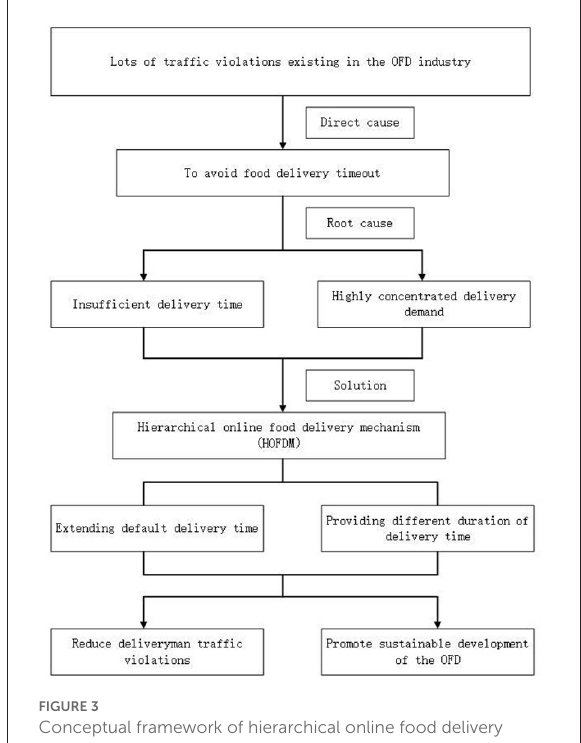
FIGURE3 Conceptual framework of hierarchical online food delivery